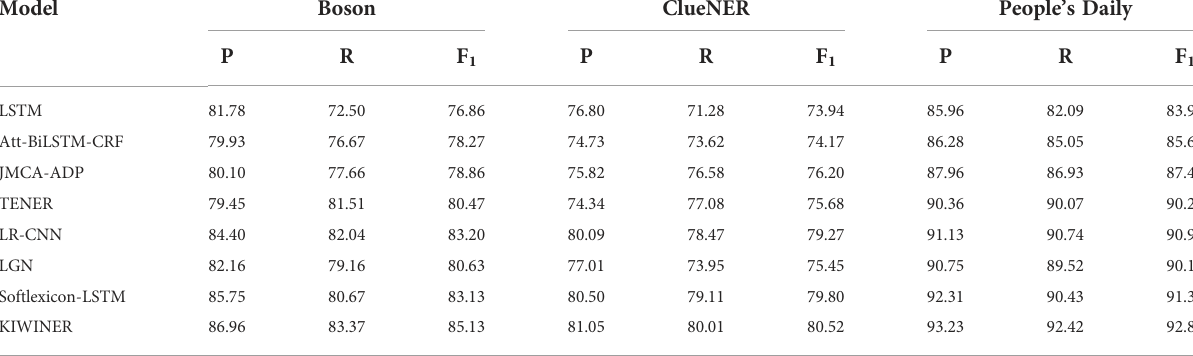
TABLE 5 Results for each model on public datasets.